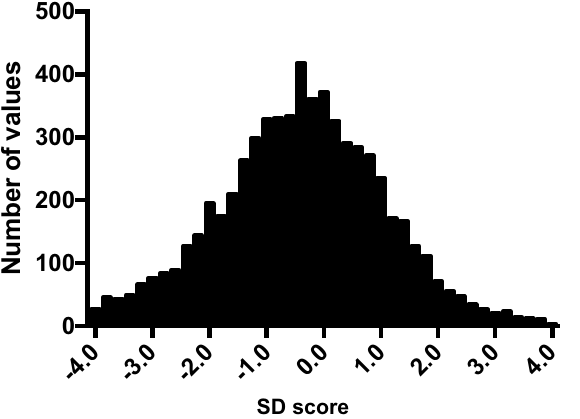
Figure 2. Distributions of SD score of BMI of pediatric population in intensive care units. The bin width of each bar is 0.2. There are 278 data points outside the axis limit. SD, standard deviation; BMI, body mass index.